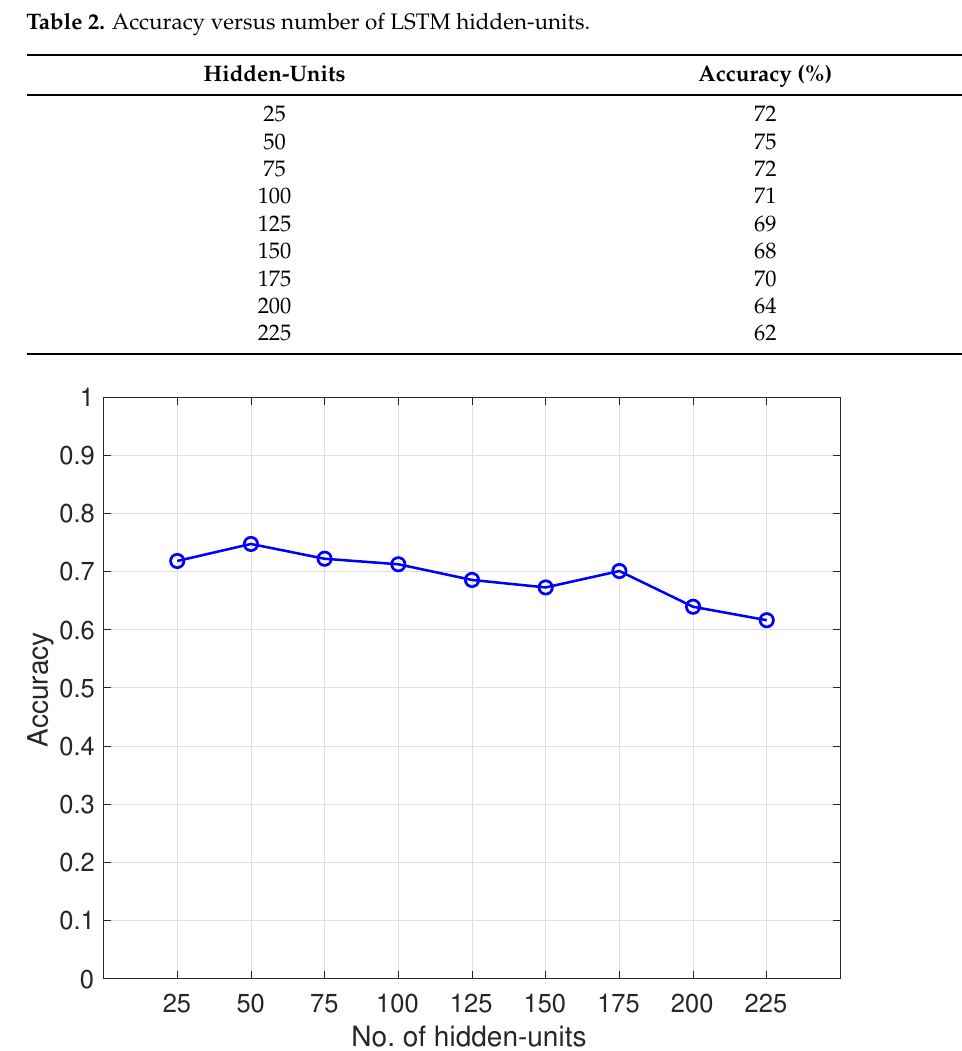
Figure 9. Accuracy versus number of LSTM